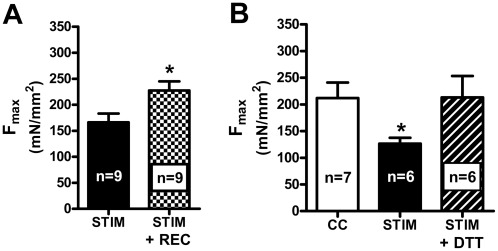
Effects of muscle recovery in vitro and DTT treatment of skinned fibers.
A: Mean Fmax (+s.e.m) in skinned fibers from SOL muscle stimulated in vitro (STIM, black bar) and fibers from the contralateral muscles similarly stimulated but allowed 45 min recovery in bath (STIM+REC, checkered bar). Fmax in fibers from STIM+REC muscle was significantly larger than in fibers from STIM muscle (denoted by *, P<0.05). (Data from contralateral muscle pairs of 2 rats). B: Fmax in skinned fibers from stimulated SOL muscles and non-stimulated contralateral muscles (CC, open bar). Alternate fibers from the stimulated muscle were examined without further treatment (STIM, n = 6, black bar) or following treatment with 10 mM DTT (10 min) prior to the first activation (STIM+DTT, n = 6, dashed bar). (Data from 2 rats). CC and STIM fibers are a subset of the data shown in Figure 2A. ‘*’ denotes significantly smaller than CC (P<0.05).